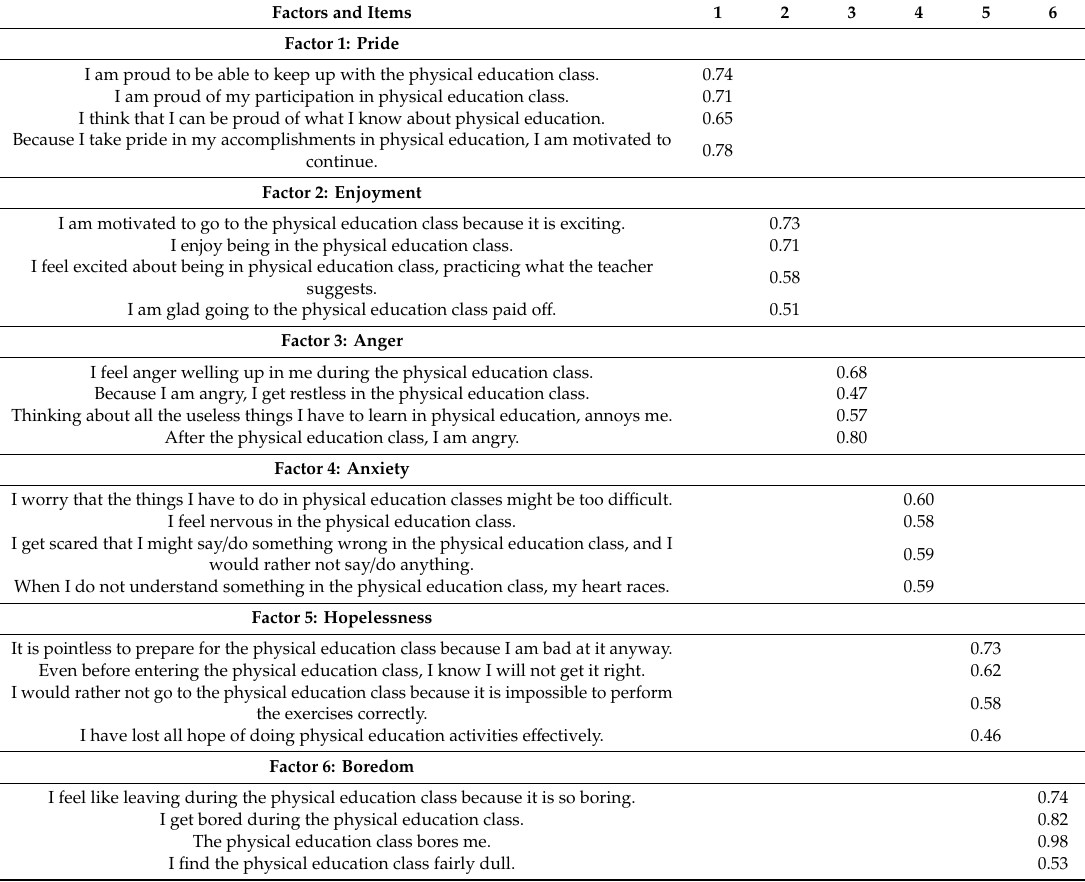
Table 3. Exploratory factor